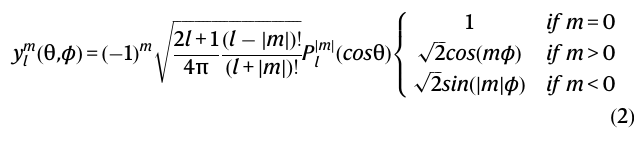
motions. b Resolution histogram comparison for CryoSparc and ZART recon- structions. The histogram shows a clear displacement of the local resolutions towards the high-resolution regime in the case of ZART. The resolution value provided in the legend of the histograms corresponds to the mean of the local resolution